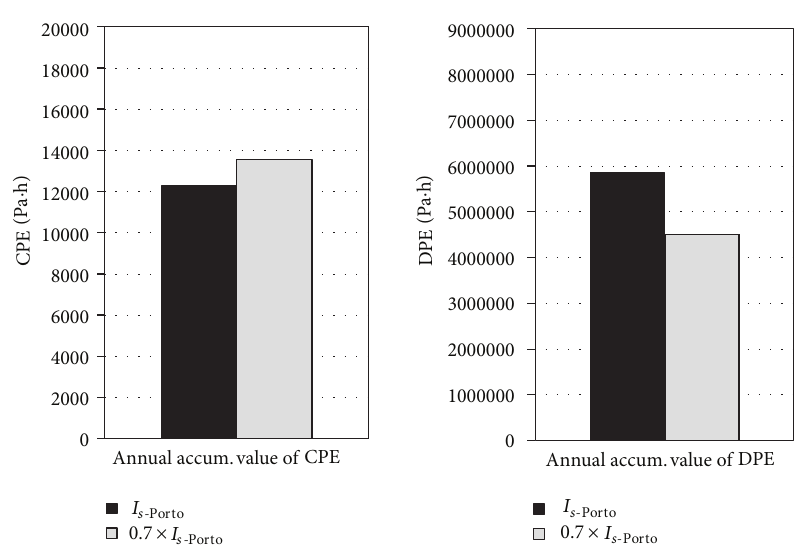
Figure 18: Exterior climate: solar